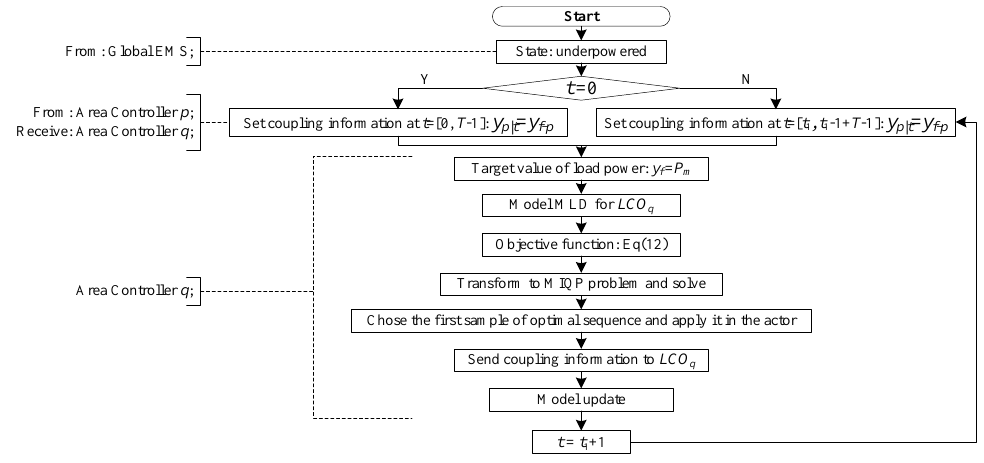
Figure 13. Block diagram of distributed predictive control of ADN flexible load.